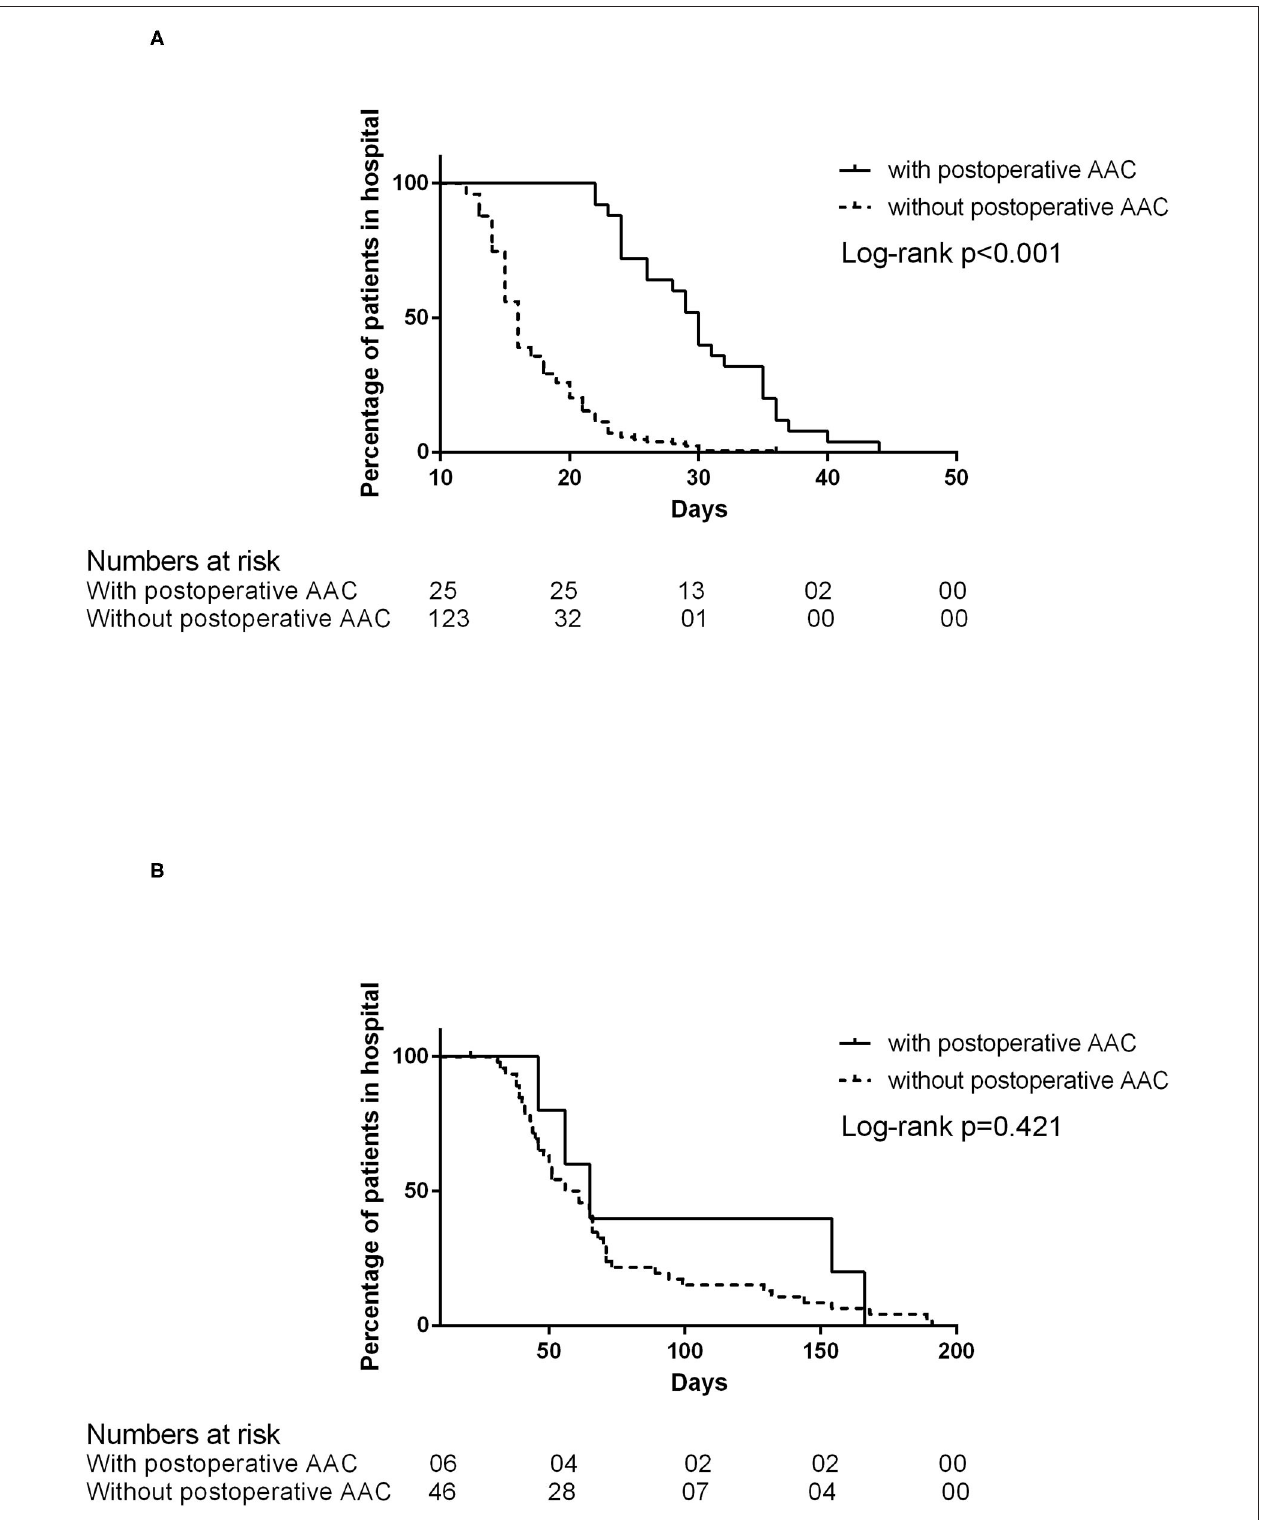
FIGURE 3 | (A) The post-operative length of stay in patients without recurrent fistula. (B) The post-operative length of stay in patients with recurrent fistula.